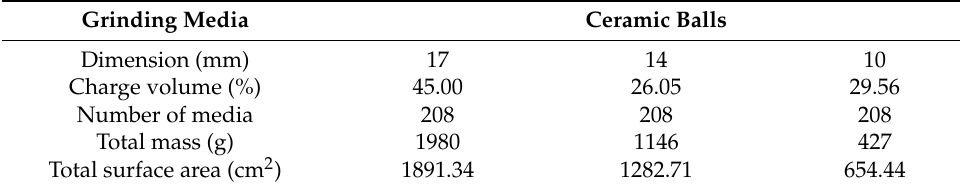
Table 6. Ceramic balls with the same total number as cylpebs (12 × 12 mm).